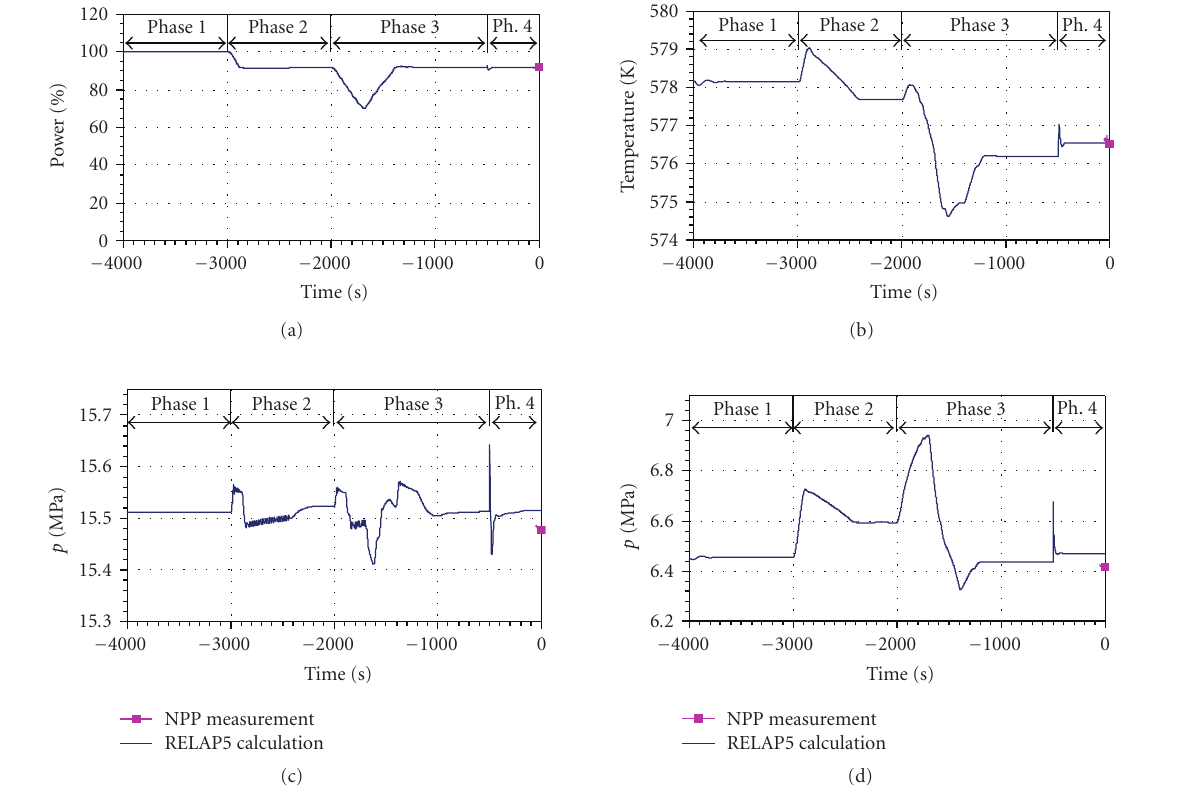
Figure 2: Achieving steady state at 91.72%: (a) core power, (b) RCS average temperature, (c) PRZ pressure, (d) SG 1